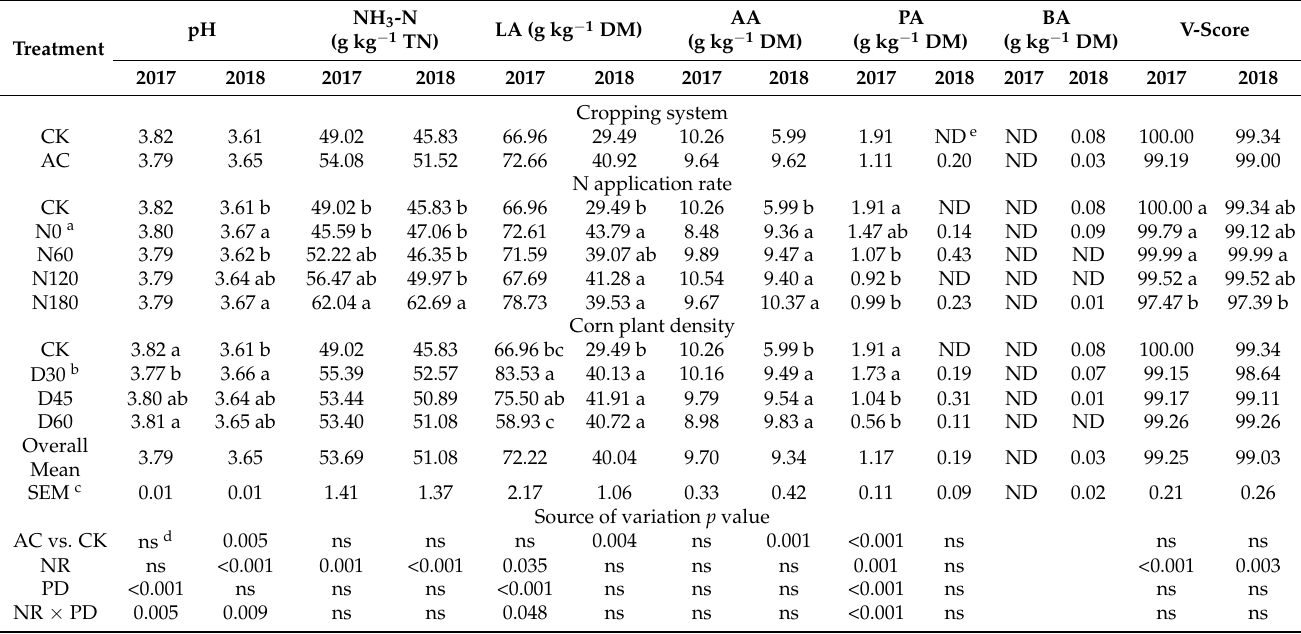
Table 4. Fermentation characteristics of the mixed silage from alfalfa–silage corn relay intercropping (AC) and whole crop corn from silage corn monoculture control (CK) affected by nitrogen application rate (NR) and corn plant density